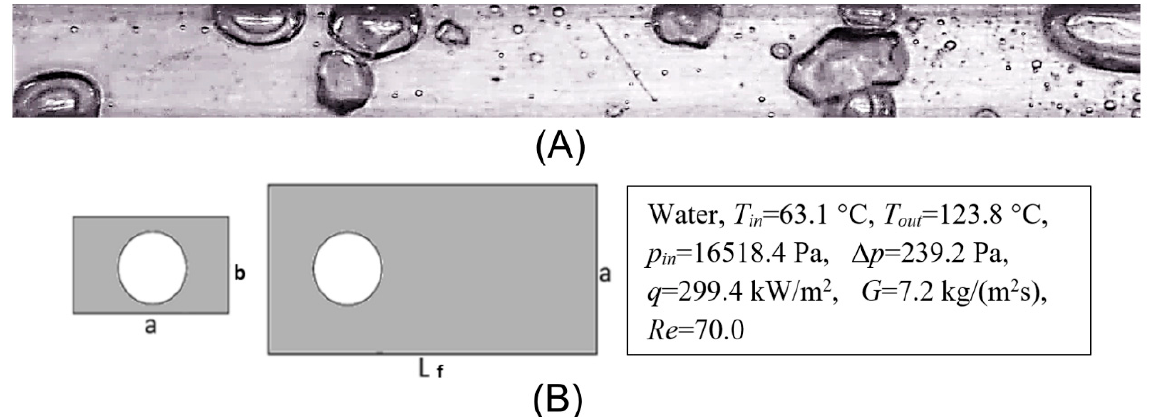
Figure 7. ( A ) Case I—top view video frame; ( B ) predicted, approximate shape of small vapor bubbles in cross section (left) and top view (right) of the mini-channel. Figure 6. ( A )—basic video frame; ( B )—after image refining (first step) and ( C )—after binarization and morphological operations (final step): water, T in = 57.5 ◦ C, T out = 102.7 ◦ C, p in = 10,234.5 Pa, ∆ p = 242 Pa, q = 333.9/(kW/m 2 ), G = 8.6 kg/(m 2 s), Re = 68.6.